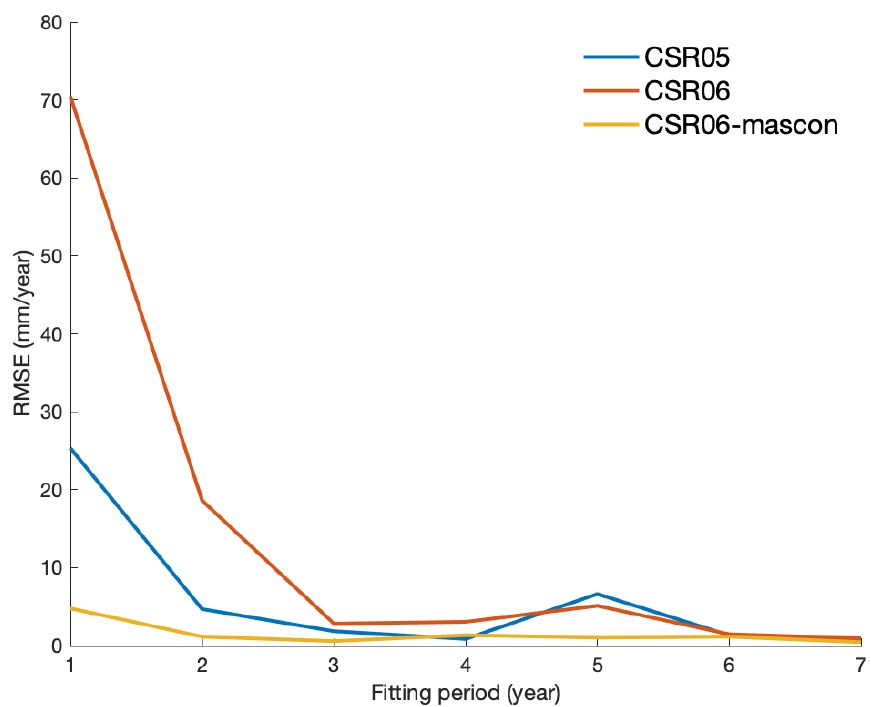
Table A3. The paired t ‐ test results for GRACE ‐ derived time lag and isotope ‐ derived age based on the 17 selected isotope samples.